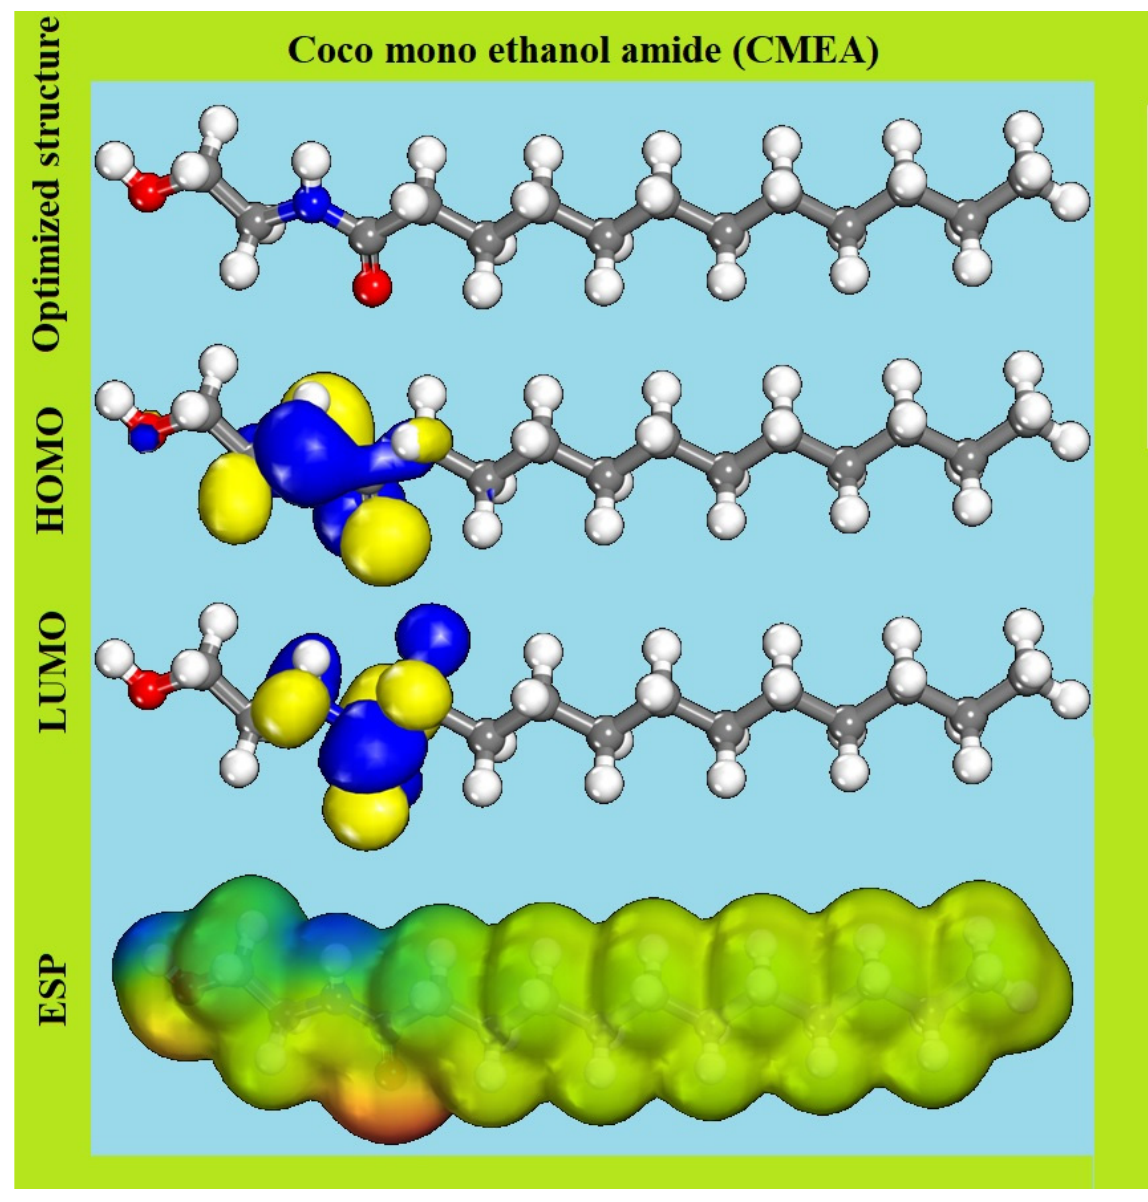
Figure 12. HOMO, LUMO, and ESP images of CMEA with optimised structure.